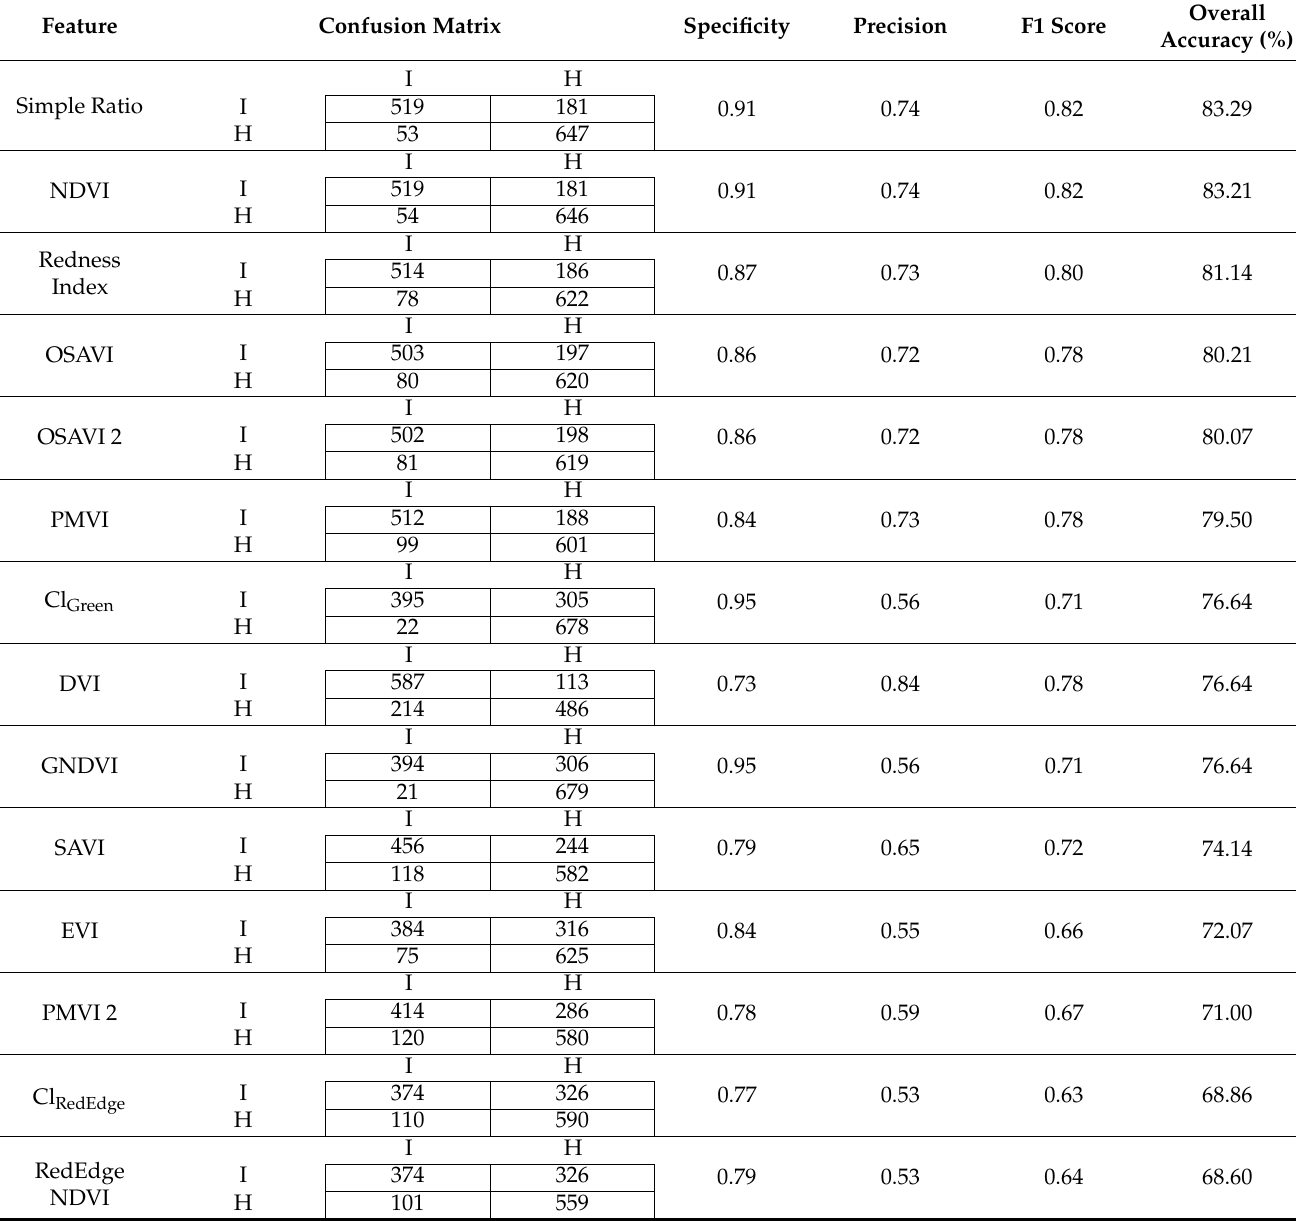
Table A2. Confusion matrix and related statistics when a fine Gaussian Support Vector Machine (SVM) classifier is trained with spectral information acquired from various spectral features computed with the Micasense© Red Edge band images to classify 700 healthy (H) and 700 infected (I) pixels from cucumber images collected inside a greenhouse. The feature is presented from the highest to the lowest overall